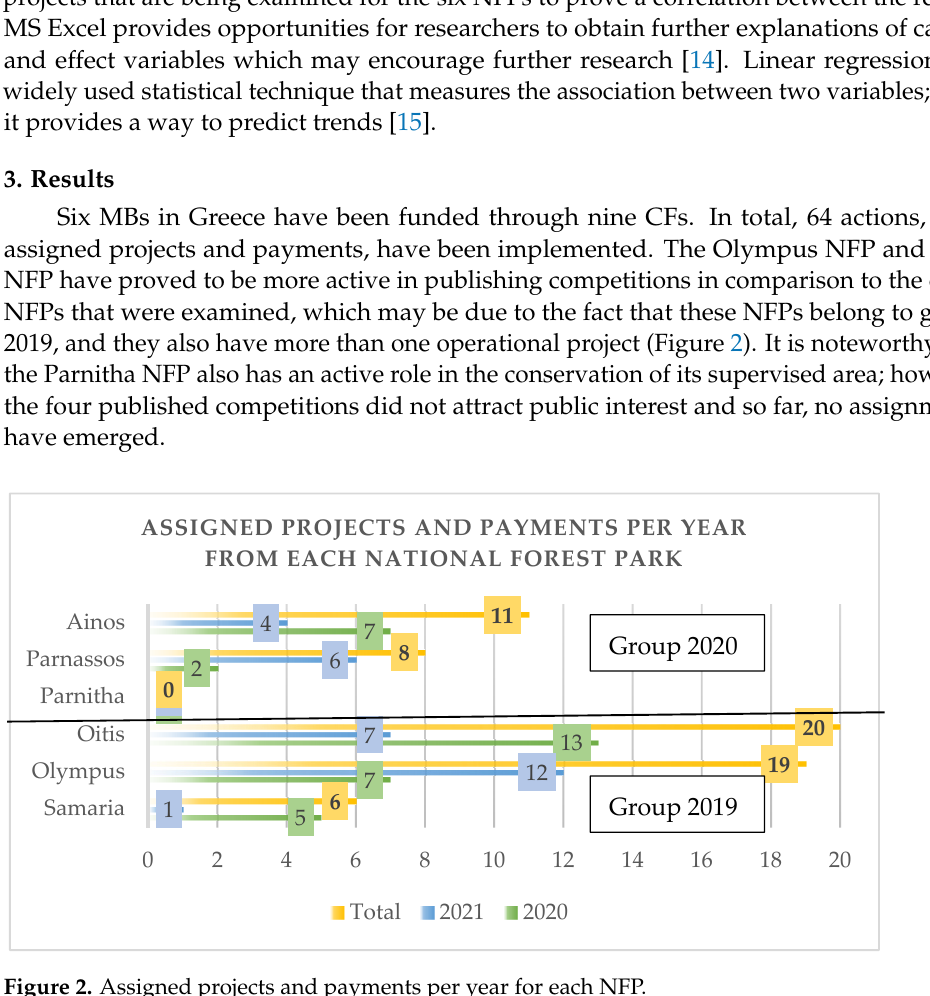
Figure 1. Methodology flow chart.